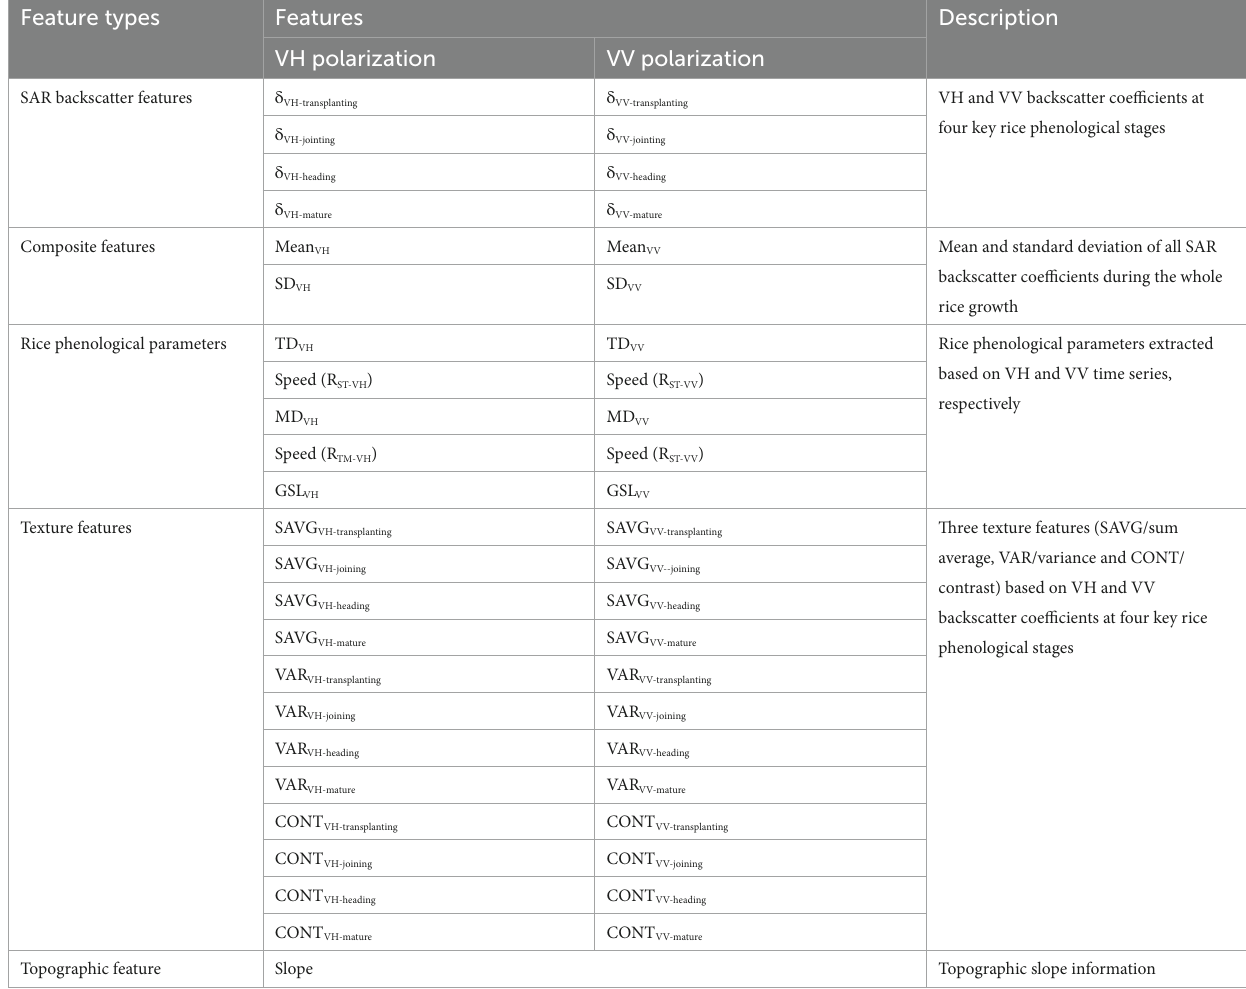
TABLE 2 Multi-characteristic parameters, including five types of features in this study.